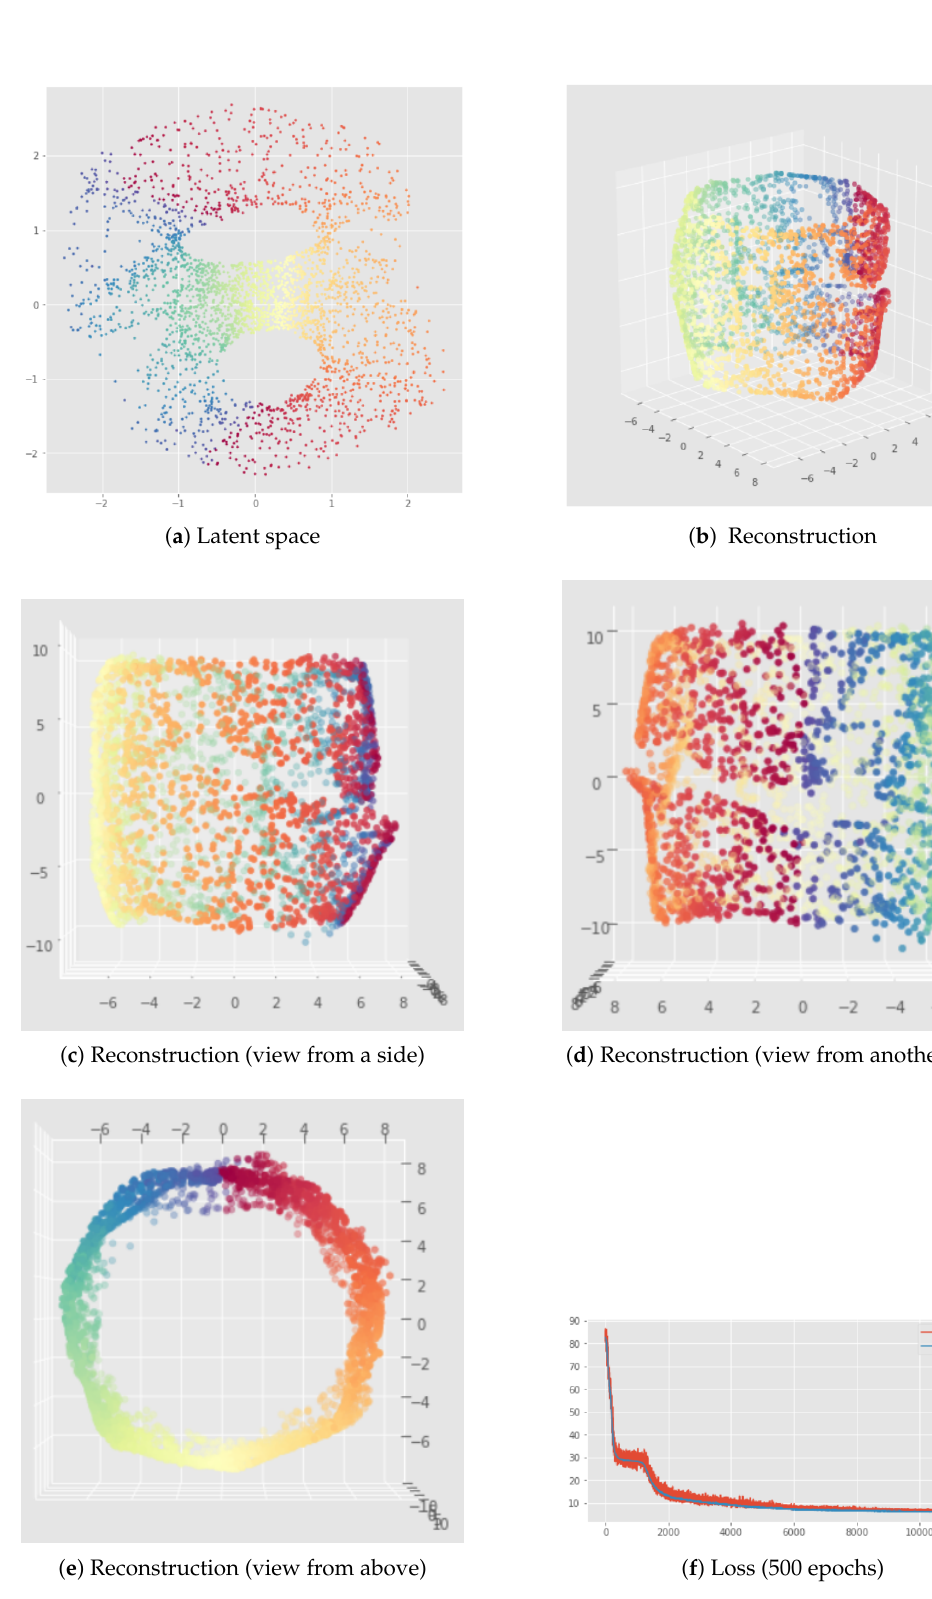
Figure 8. Standard VAE applied to the open cylinder dataset - pytorchseed = 1, trained for 500 epochs. ( a ) is the latent representation of the open cylinder in a 2-dimensional space of a standard VAE. We can see two 1-dimensional holes so β 1 = 2 (Betti number 1 is equal to 2) instead of 1. ( b – e ) are different views of the reconstruction in the original 3-dimensional